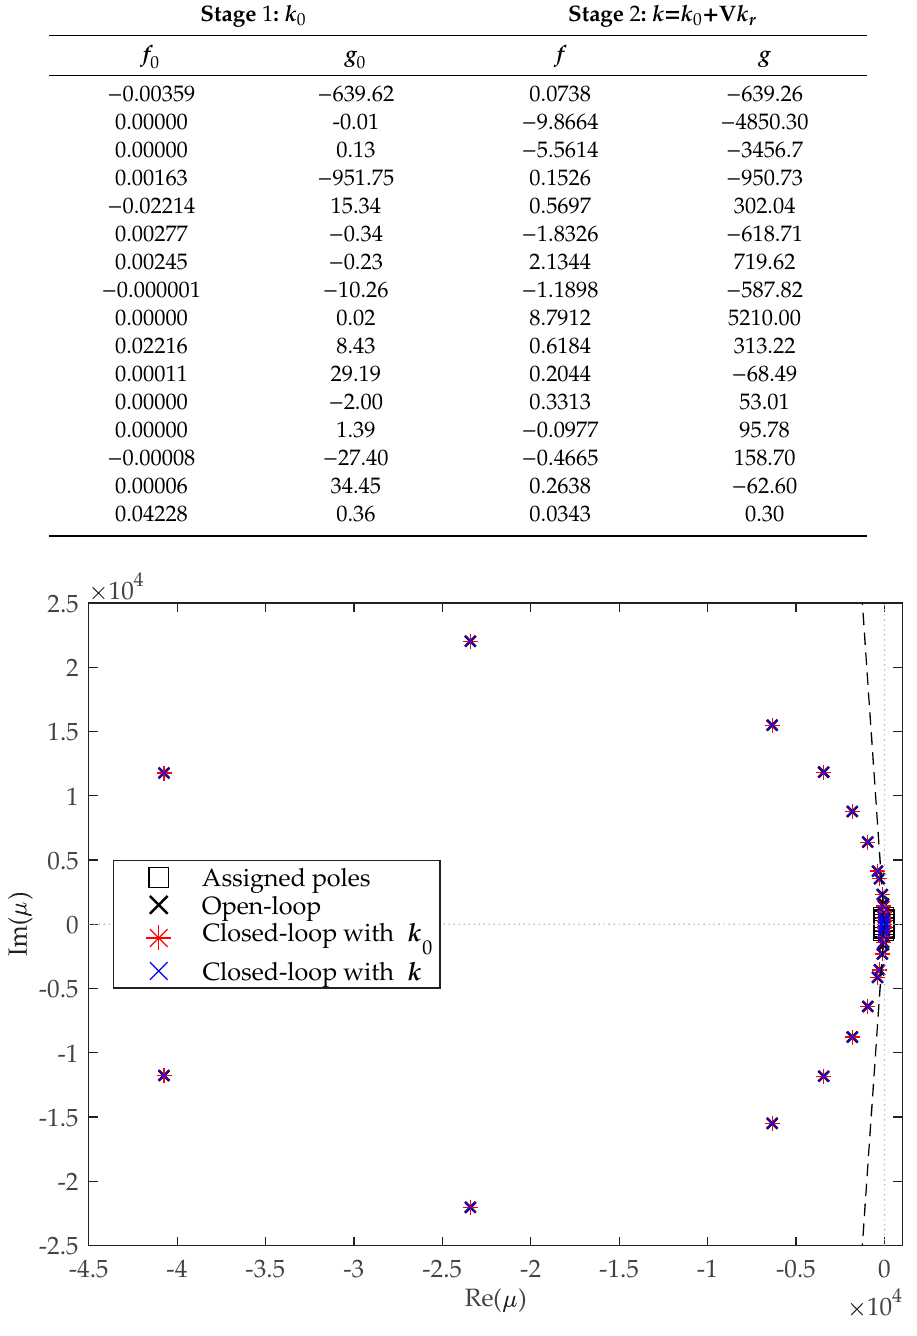
Figure 11. Open-loop and closed-loop poles of the four-bar linkage (test-case 4).